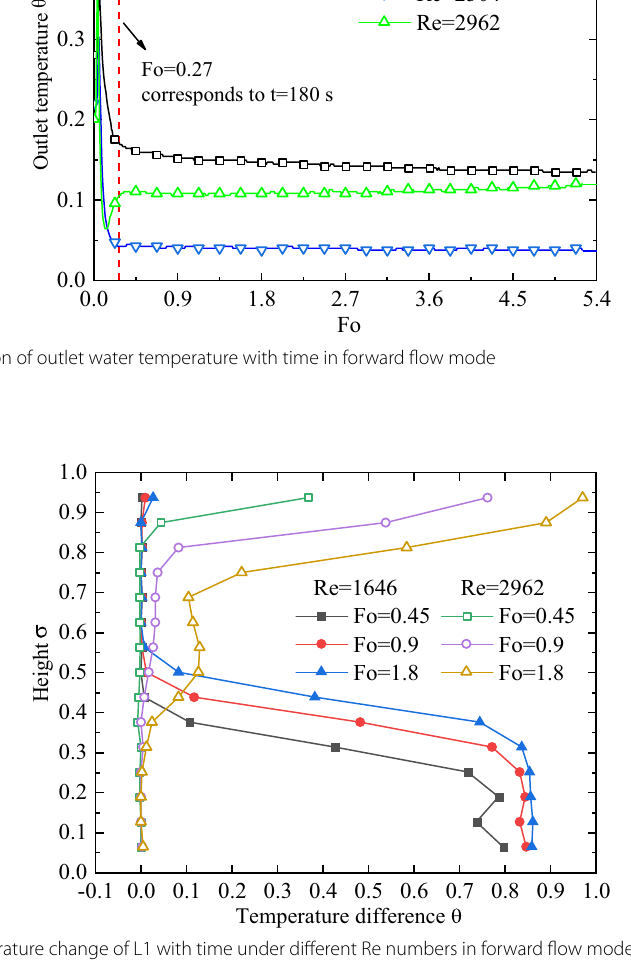
is 1646, only the temperature measurement point near the bottom of the sandbox has a temperature change and this temperature change gradually increases with the increase of operating time, while the temperature of the temperature measurement point near the top of the sandbox hardly changes. The change of temperature differ- ence θ shows that the thermal influence on the inside of the sandbox increases signifi- cantly with the increase of operation time. Moreover, the temperature change of L1 is the contrary while the Re increases to 2962. This shows that the difference in inlet flow rate in the forward flow mode has a great impact on the convective heat trans- fer inside and outside the screen tube. In order to further study the above phenom- enon and explain such behavior, the experimental conditions with Re of 1975, 2633 and 3291 are supplemented, and other conditions remain unchanged. The results are shown in Fig. 8.